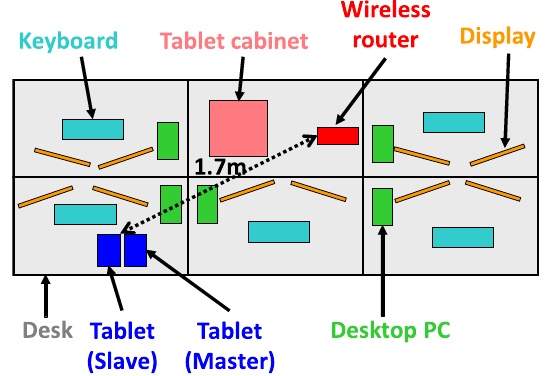
Fig. 1 How to measure all-RTT and last-RTT